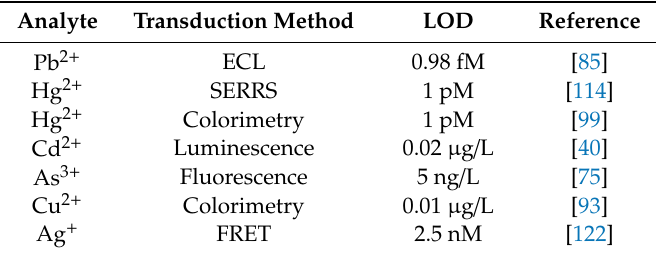
Table 2. Most sensitive transduction methods, with respect to the specific analyte (n. of published works ≥ 2), applied in real samples.